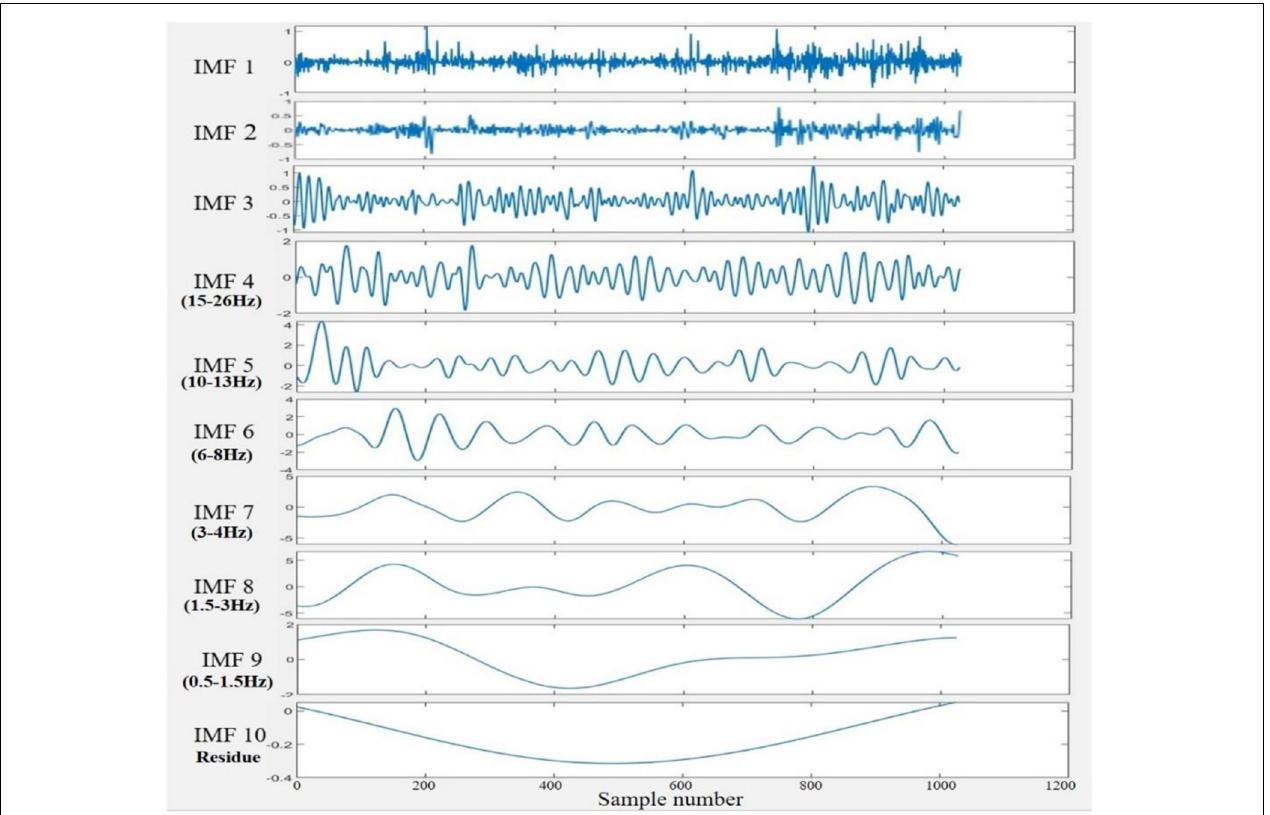
FIGURE 4 | An example of a set of IMFs resulted from the NA-MEMD decomposition of the 2 s EEG signal. IMF1 to IMF3 considered noisy, and IMF10 represented the residue mode. IMF4 to IMF6 were localized in the beta, alpha, and theta bands, respectively, while IMF7 to IMF9 belonged to the delta